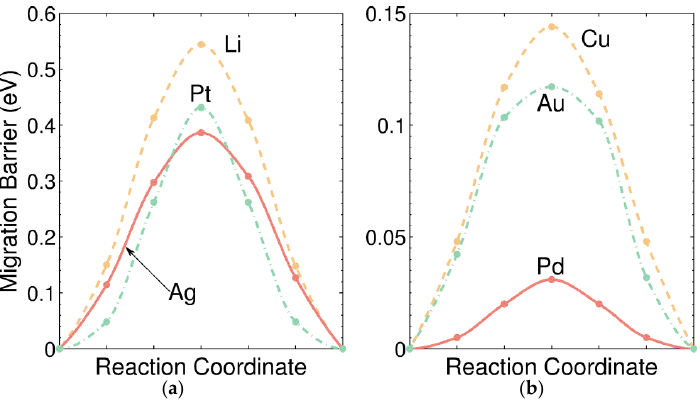
Figure 6. The migration energy barriers for metals ( a ) Ag, Pt, Li and ( b ) Pd, Au, and Cu in Ge through the direct interstitial mechanism. Copyright 2015 Royal Society of Chemistry [64].